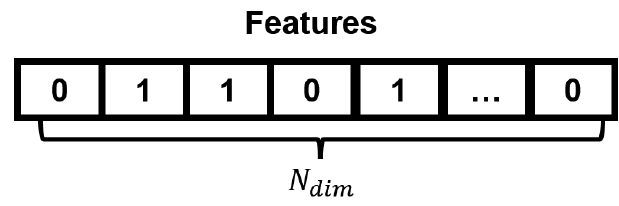
Figure 1. Feature selection model with binary solution